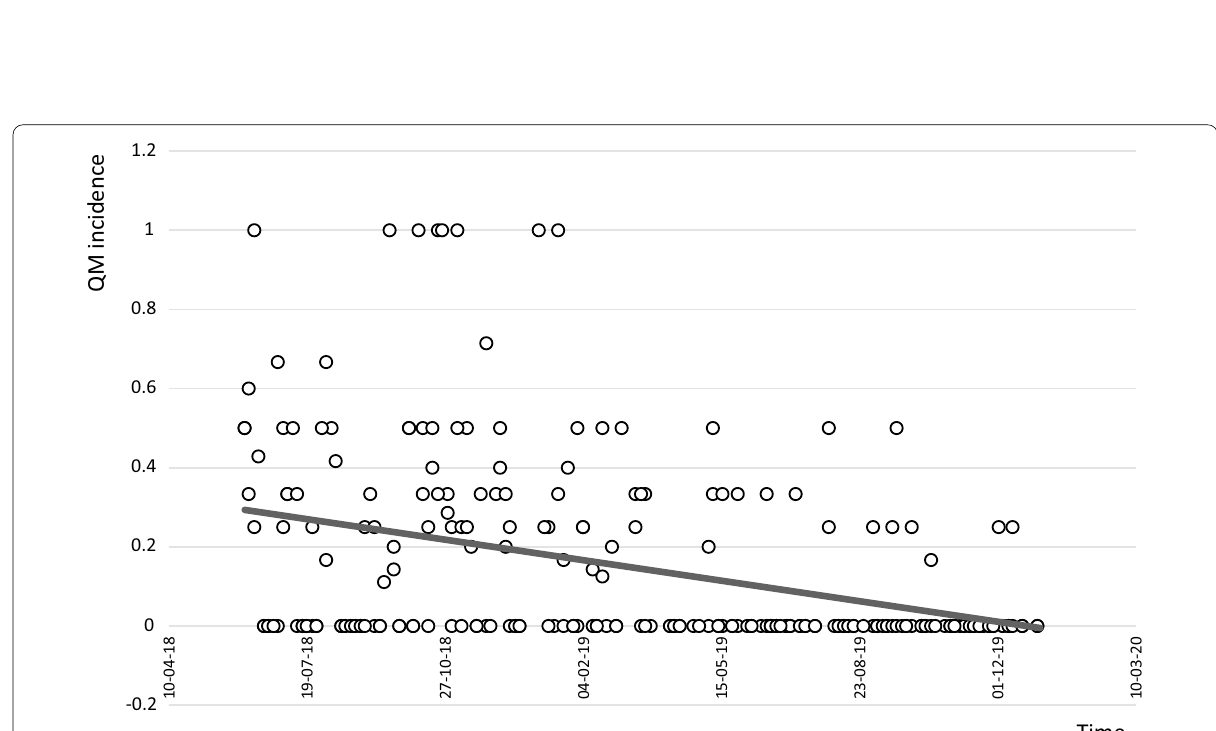
Fig. 2 QM events by category. QM events were categorised into incidents related to indication ( n reporting ( n 106, 76.3%). The standardised protocol used for documentation of MDCs has a box for entering free text (QM comments), which was = used in 658 (67.6%) of all examinations presented in an MDC ( n and explained the respective event. In examinations not affected by QM events, QM comments provided general feedback for further improvement